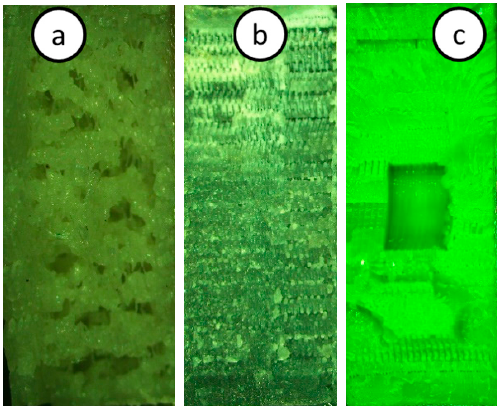
Figure 18. Optical microscopic images (10 × magnification) at the fractured surface ( a ) White ( b ) Gray ( c ) Green.